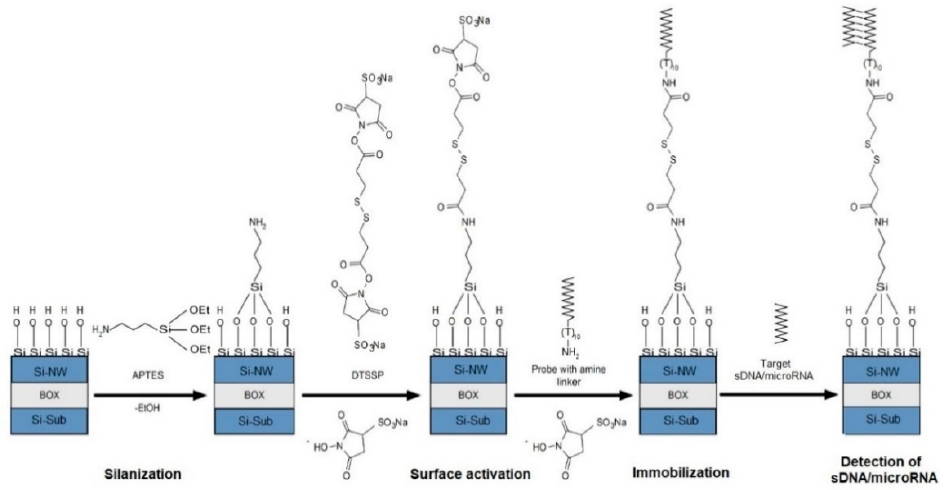
Figure 2. Schematic representation of the processes of chemical modification and sensitization of the nanochip surface. nanochip